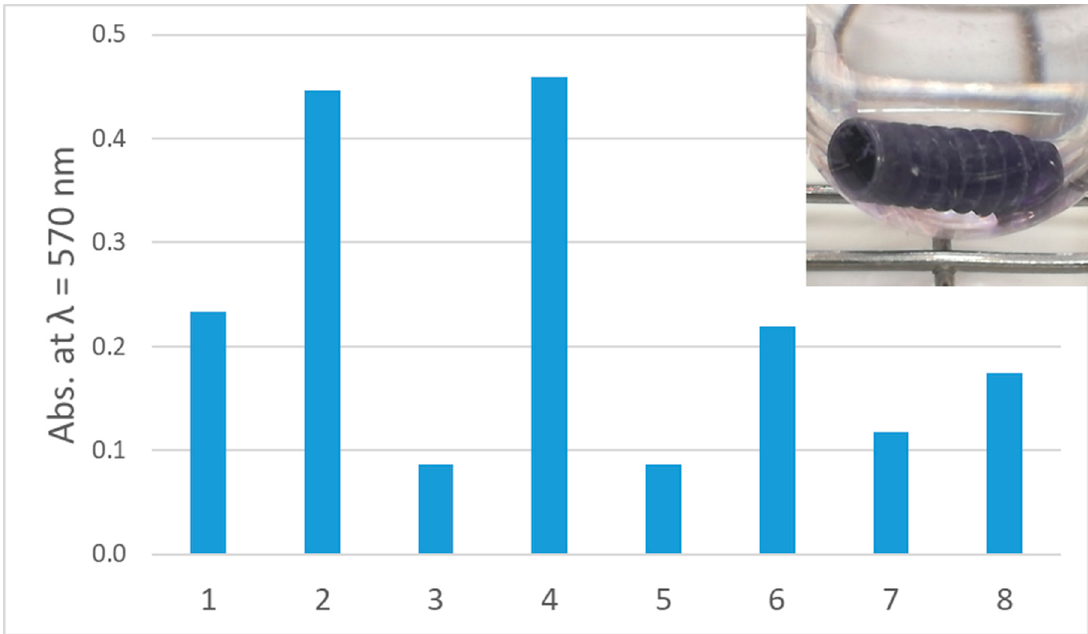
Figure 5. Biofilm formation on implants. Quantitative analysis of biofilm formation: (1) B. pumilus , (2) B. subtilis , (3) C. albicans , (4) C. dubliniensis , (5) E. faecalis , (6) R. mucosa , (7) S. epidermidis , (8) S. sanguinis . Inset: Crystal violet staining of R. mucosa